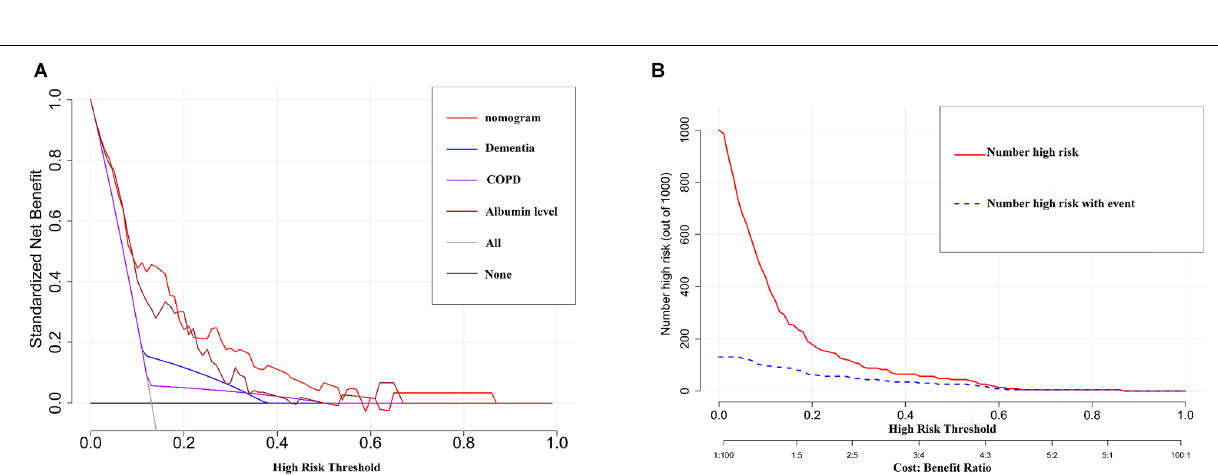
Frontiers in Aging Neuroscience | www.frontiersin.org